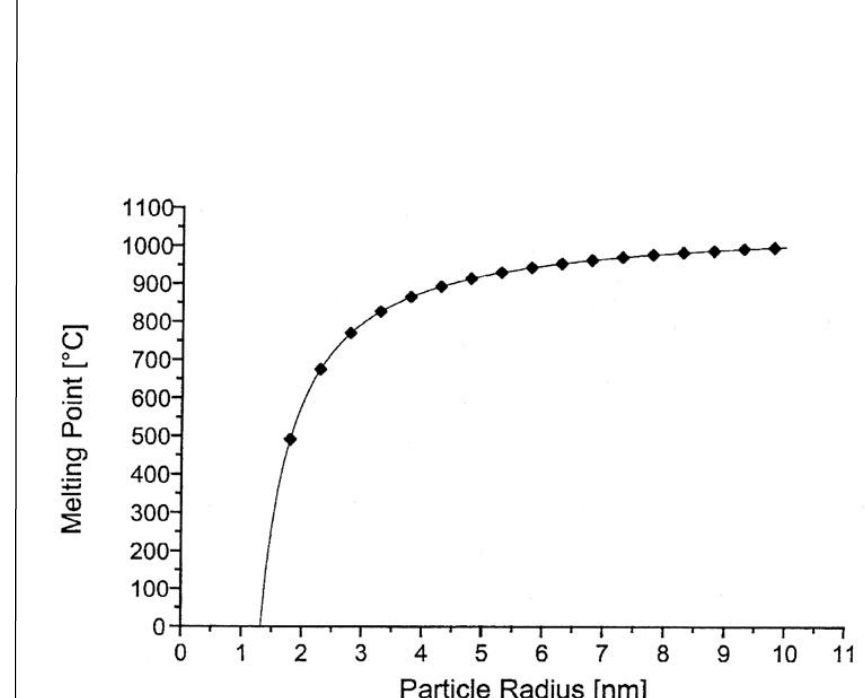
Figure 3 – Change of the melting point depending on the gold particle radius (Buffat, Borell, 1976,